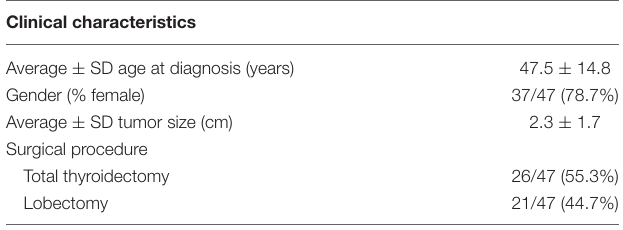
TABLE 1 | Baseline characteristics of the study cohort.